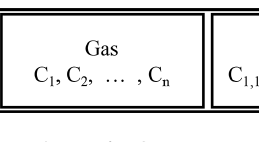
Figure 1. Array layout for ODE states y in Eq. (5).